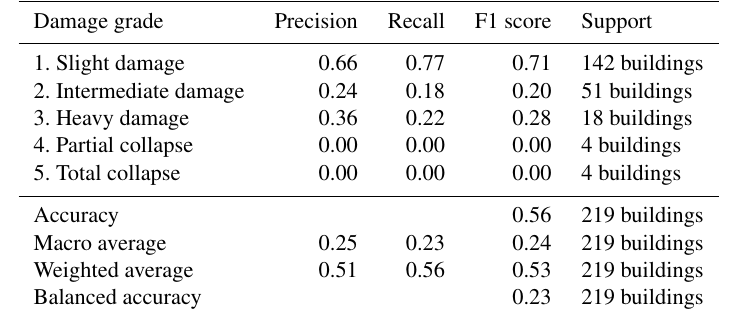
Table 4. Test-set performance metrics for multi-class classification for the 2017 Puebla earthquake.